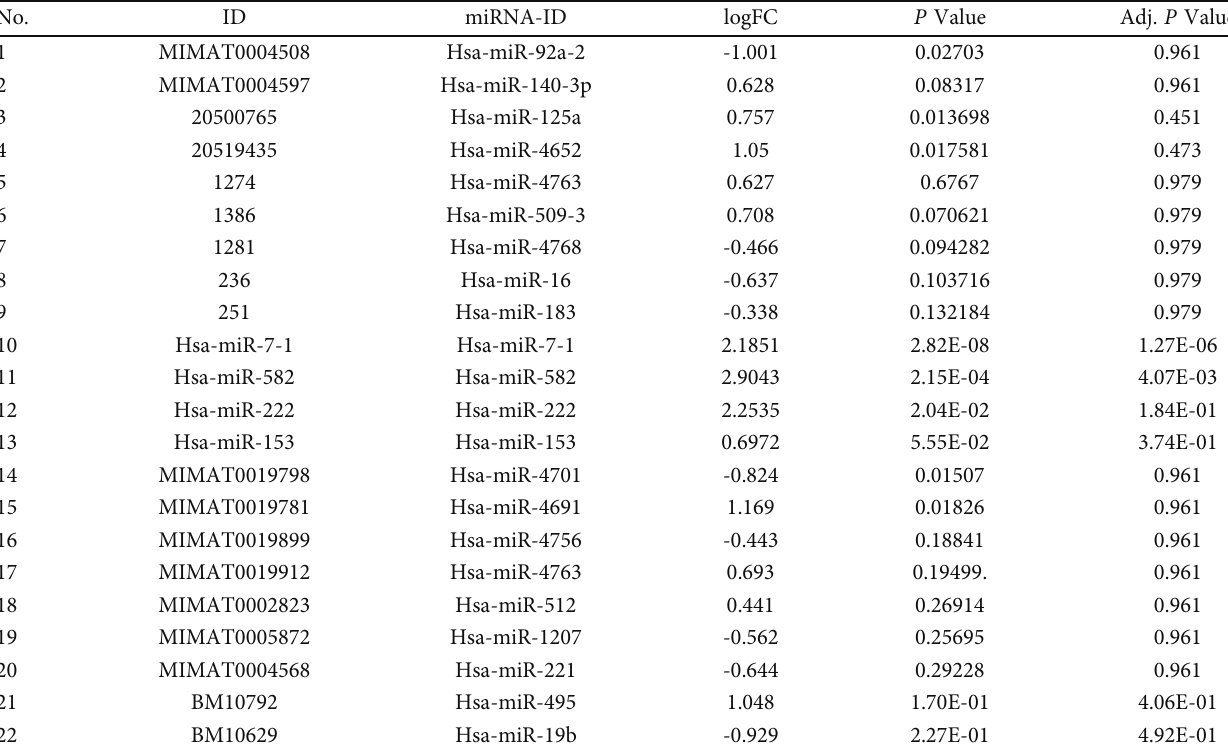
Table 2: Two microRNAs expressed in colorectal cancer cell line compared with control colorectal cell according to data from the GEO